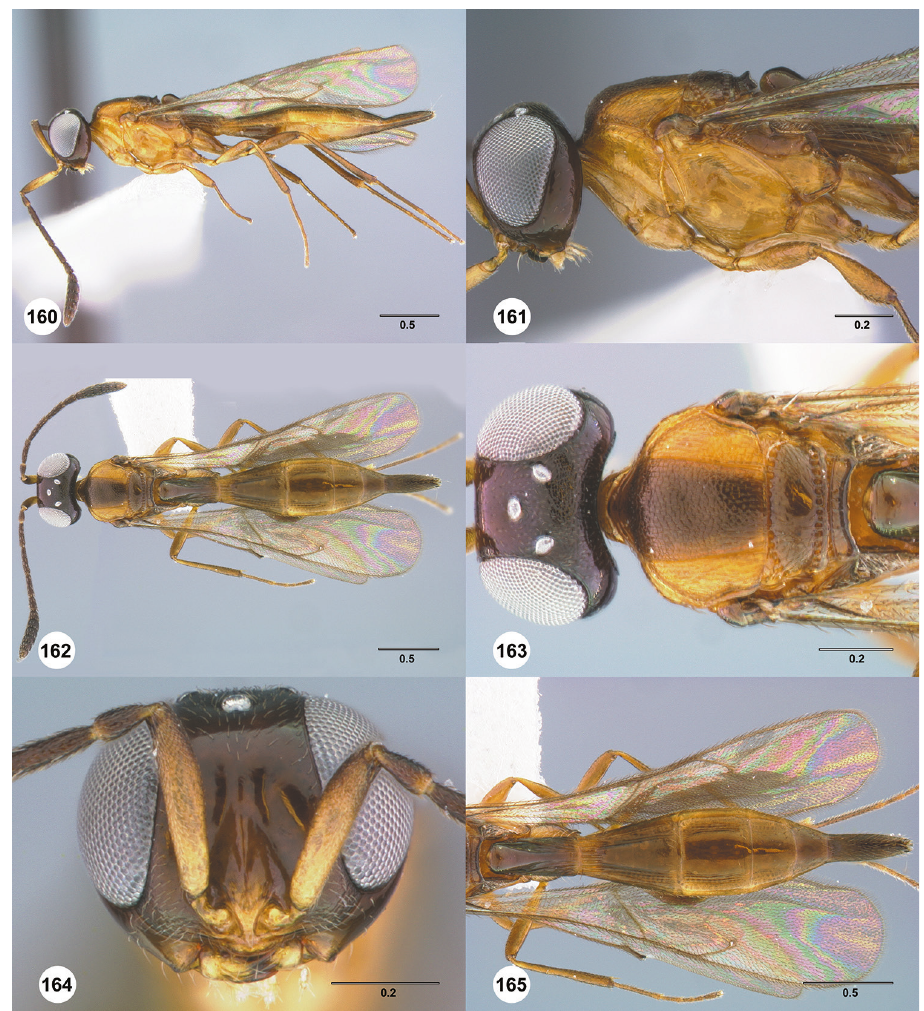
tus 161 Head and mesosoma, lateral view 162 Dorsal habitus 163 Head and mesosoma, dorsal view